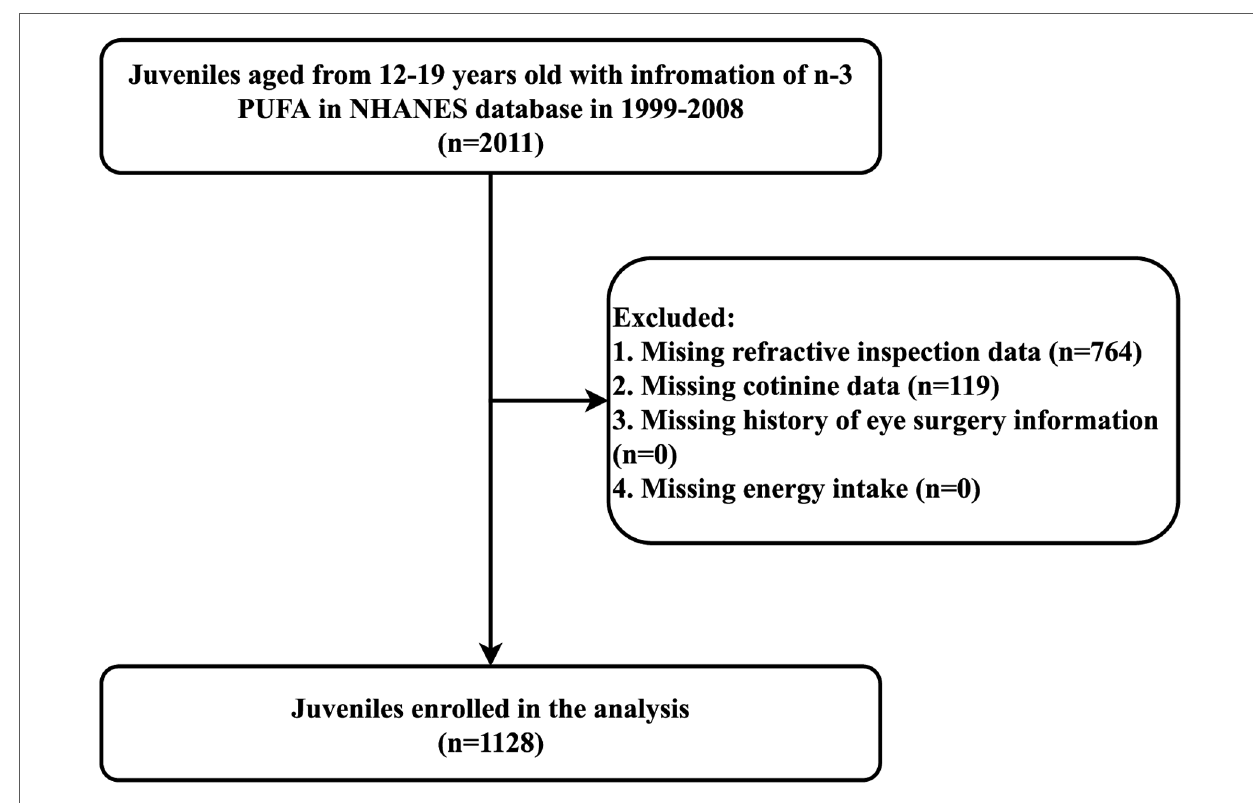
FIGURE 1 The fl ow chart of data